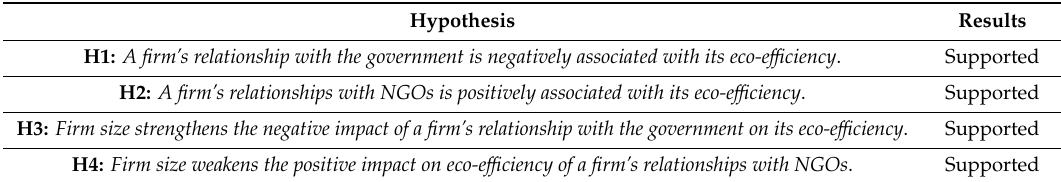
Table 3. Summary of hypothesis testing.